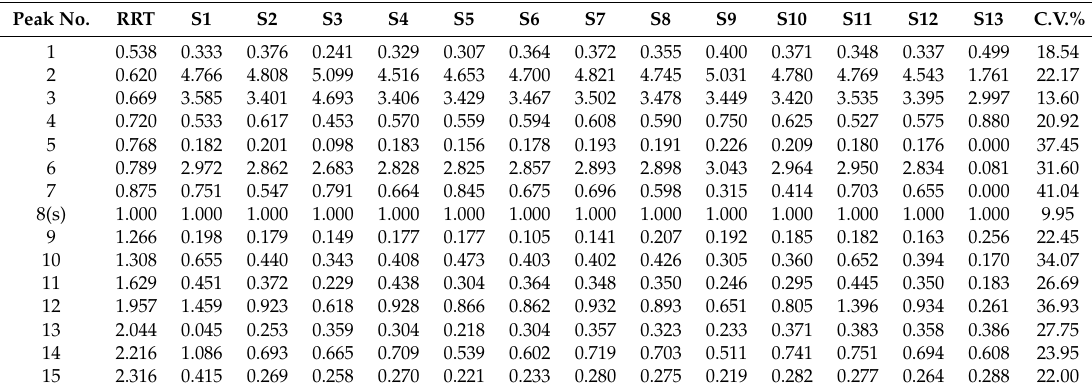
Table 1. The relative retention time (RRT) and relative peak area (RPA) of the common peaks of the collagen peptides. C.V.%: coefficient of variance.